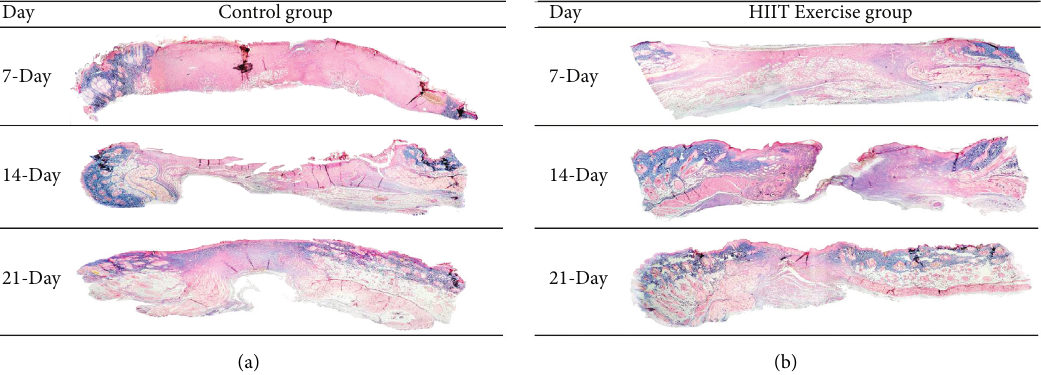
Figure 6: Histological analysis of control (a: × 40) and HIIT exercise (b: × 40) with Masson’s trichrome